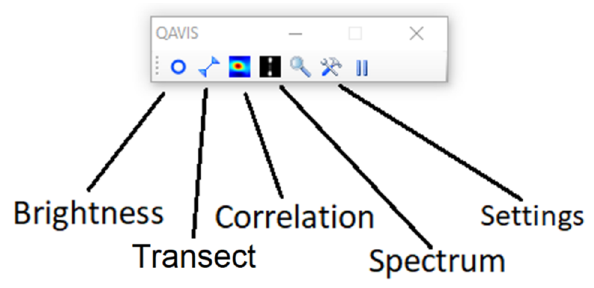
Figure 3. QAVIS Main Menu.